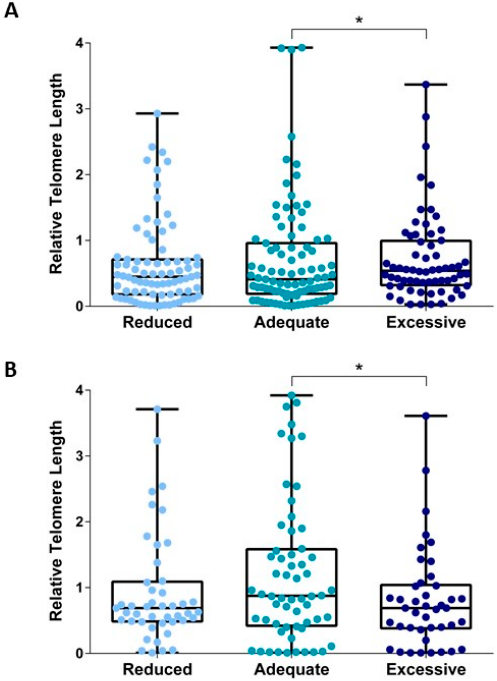
Figure 2. The relationship between categories of gestational weight gain and relative telomere length. ( A ) shows the box plots of telomere length of mlDNA according to GWG categories; ( B ) shows the box plots of telomere length of cfDNA according to GWG categories. * p -value < 0.05 based on the Mann–Whitney test.